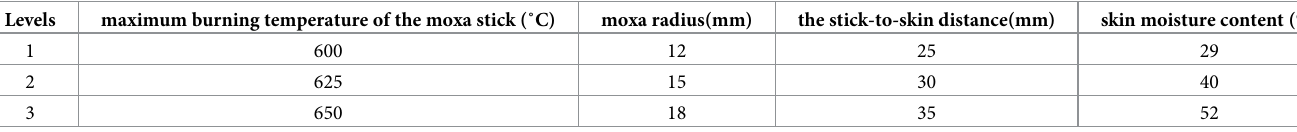
Table 2. Parameter values at each